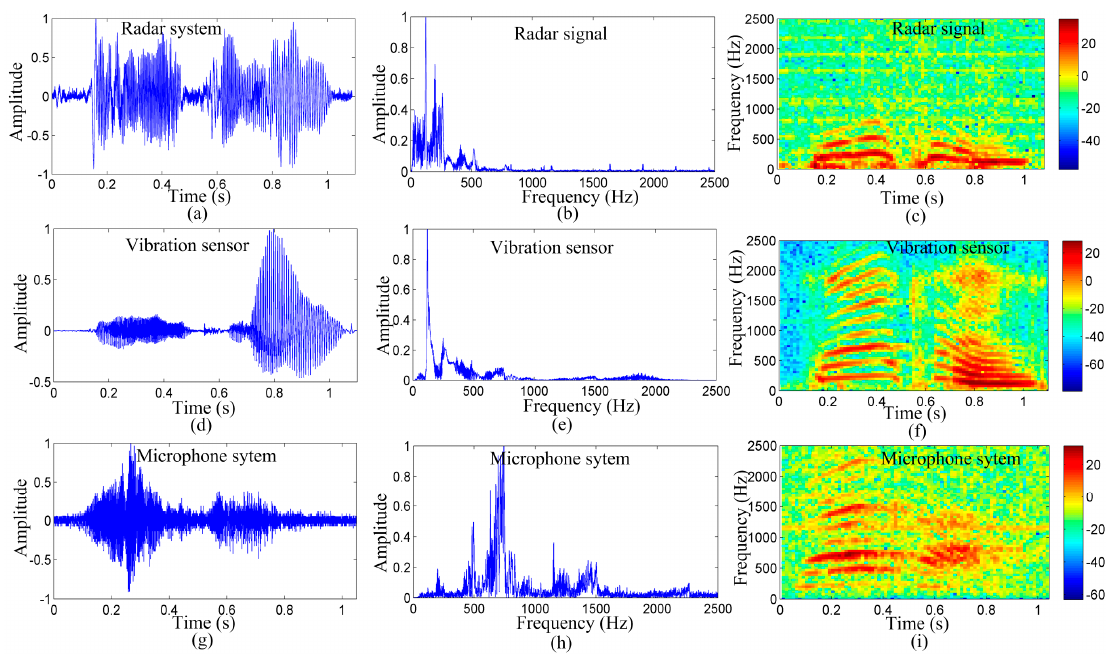
Figure 8. Measurement results of the radar system, vibration measurement sensor, and microphone system for the word “welcome” as spoken by a young adult male. Time-domain waveforms, frequency-domain spectrum, and spectrograms of the signal detected by, ( a – c ) the radar system, respectively; ( d – f ) vibration sensor, respectively; and ( g – i ) microphone system, respectively.